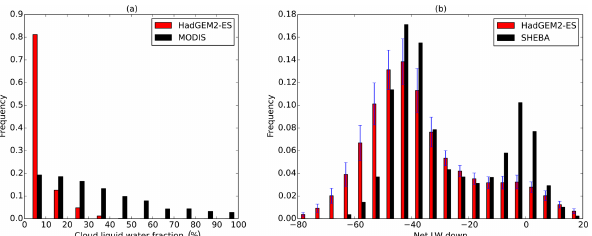
Figure 9. Frequency distributions of (a) October–April cloud liquid water percentage in HadGEM2-ES compared to MODIS observa- tions, for the Arctic Ocean region. (b) December–February surface net downwelling LW in HadGEM2-ES in the SHEBA region, com- pared to the values observed at